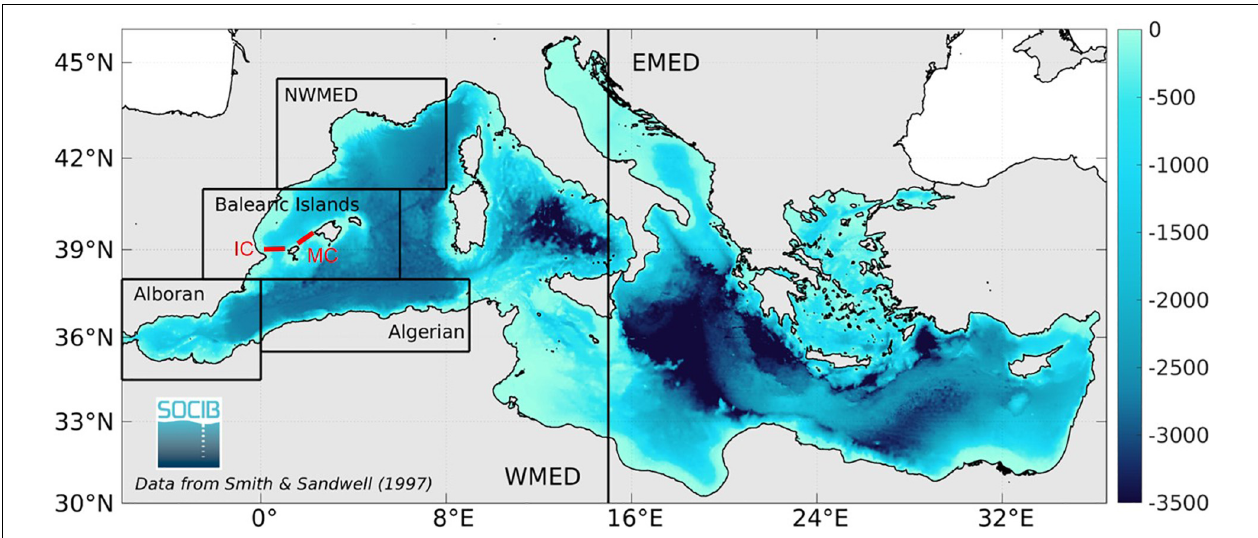
FIGURE 1 | Bathymetry (in m) in the Mediterranean Sea with the sub-regions (black boxes) and sections (red lines) used for the current sub-regional ocean indicators: eastern and western Mediterranean (EMED and WMED), north-western Mediterranean (NWMED), Balearic Islands region (including the Cabrera Island National Park), Alboran Sea, Algerian sub-basin, Ibiza and Mallorca Channels (IC and MC).